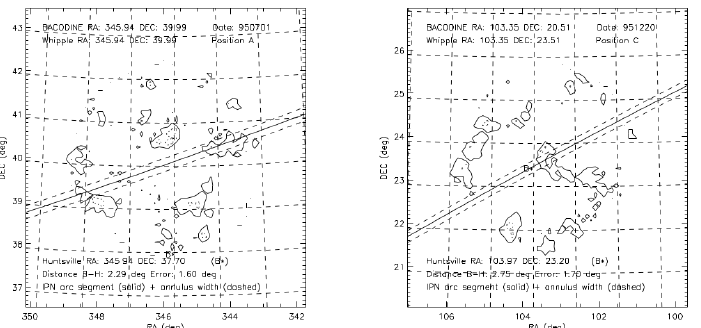
Figure 4. Excess sky map for two pointing positions during the follow-up of two GRBs by Whipple telescope in 1995. The refined position of the event is marked as B* in the plot while the IPN confidence areas are derived from BATSE and Ulysses data. Reprinted with permission from Ref.